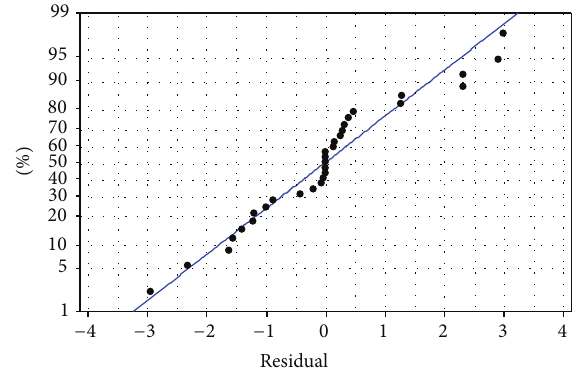
Figure 3: Normal probability plot for the experimental